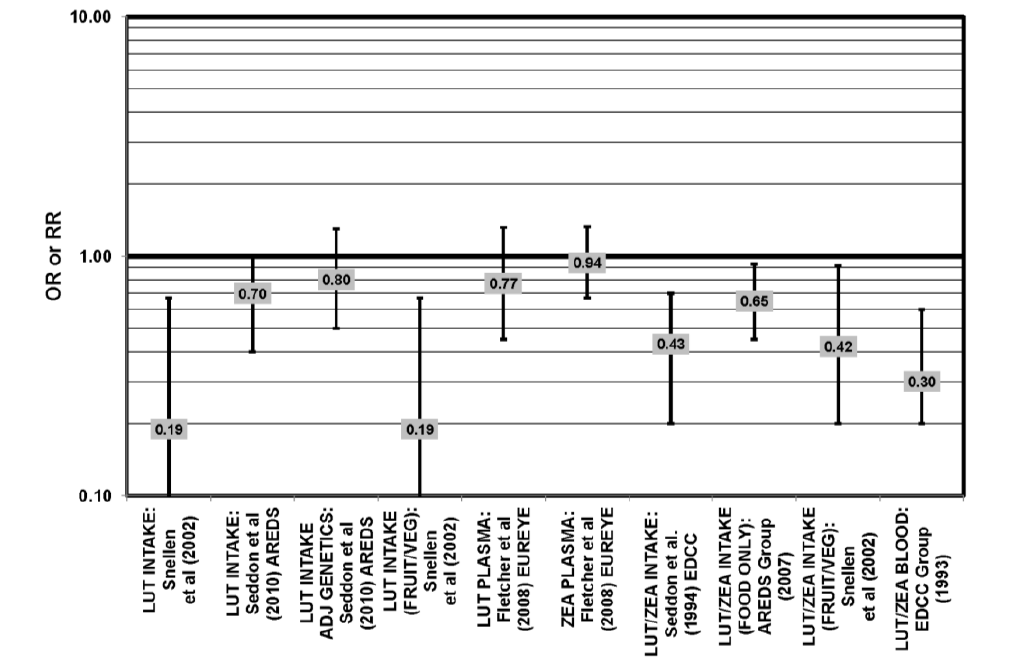
Figure 29. Odds or risk ratio for exudative or neovascular AMD; high vs. low intake or blood levels of lutein and/or zeaxanthin: retrospective and cross-sectional